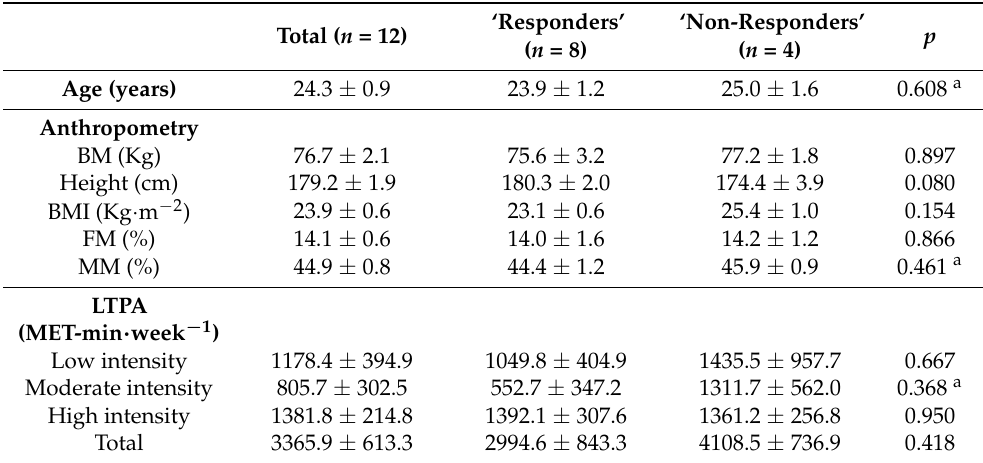
Table 1. Characteristics of the